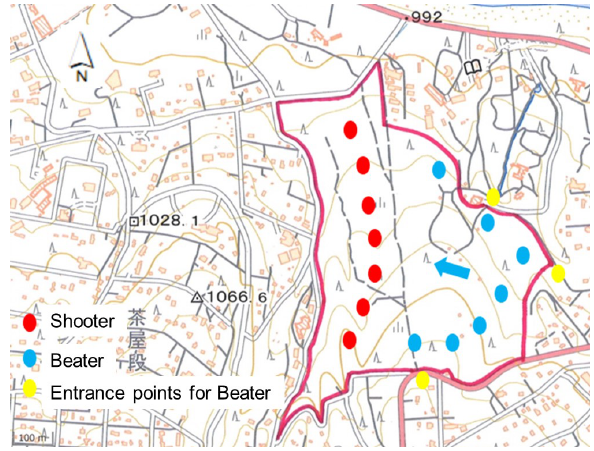
Figure 1 . Study area (red line) covers Fuji Iyashinomori Woodland Study Center (FIWSC), the University of Tokyo Forests and adjacent Yamanakako Forest Park of Literature in